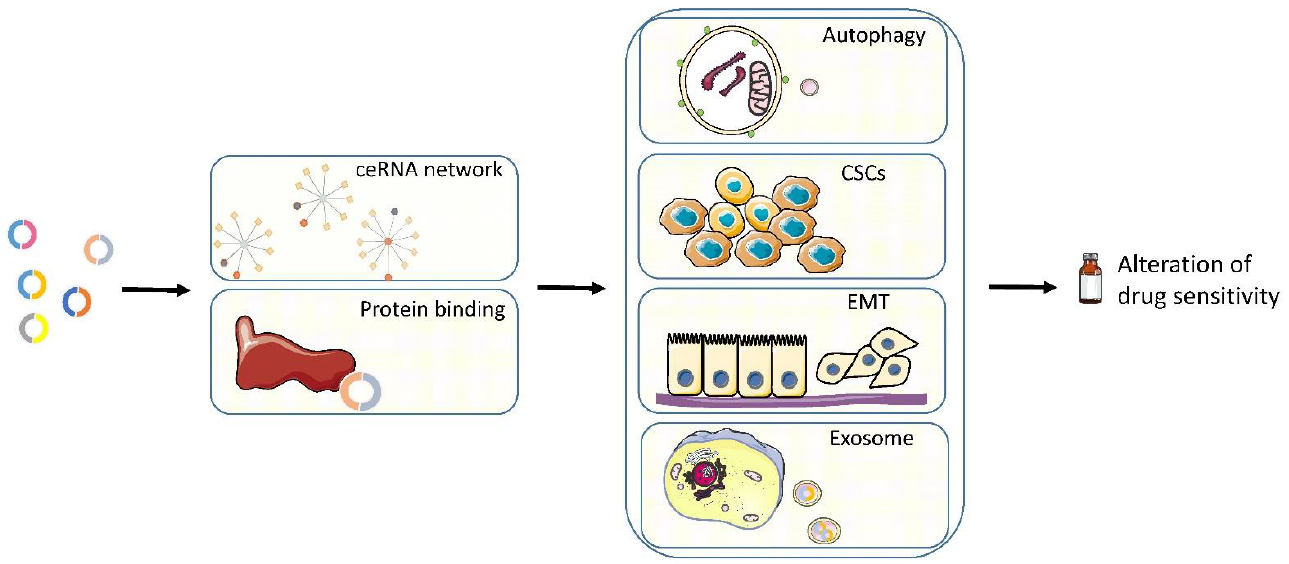
Figure 3. The mechanisms via which circRNAs regulate the sensitivity to systematic treatments in genitourinary cancers. CSCs: cancer stem cells, EMT: epithelial–mesenchymal transition. genitourinary cancers. CSCs: cancer stem cells, EMT: epithelial–mesenchymal